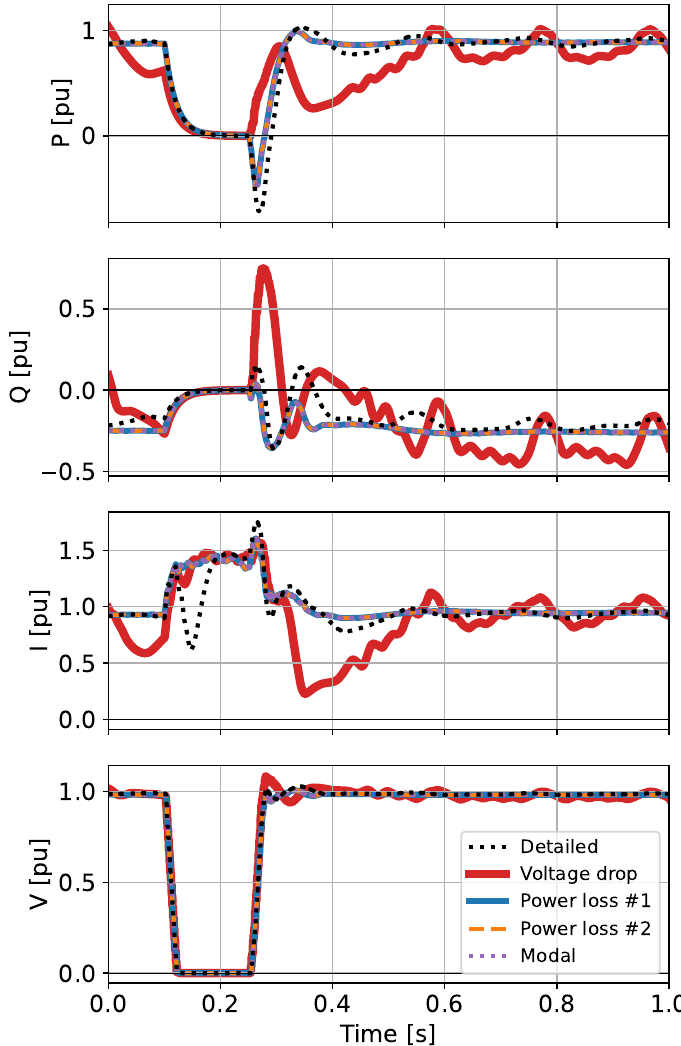
Figure 13. Time-domain simulation of case 2 with distance factor =